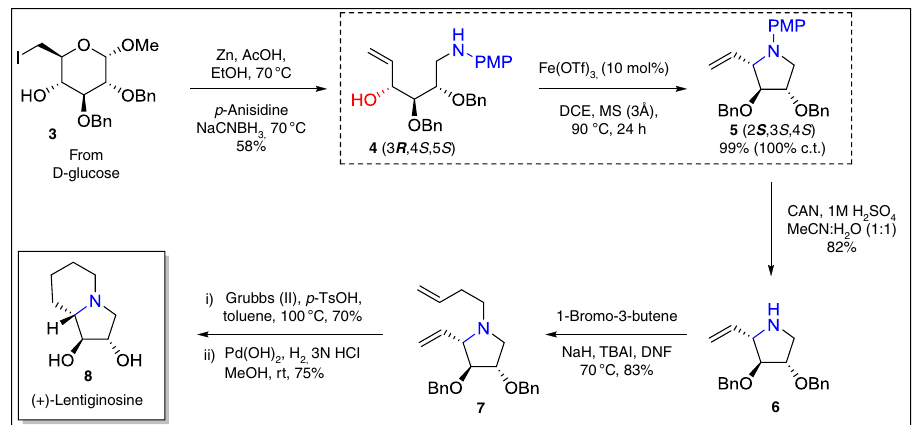
Fig. 3 Total synthesis of ( + )-lentiginosine. 100% enantiospeci fi city in the key step of the synthesis of ( + )-lentiginosine, a fi ve-membered